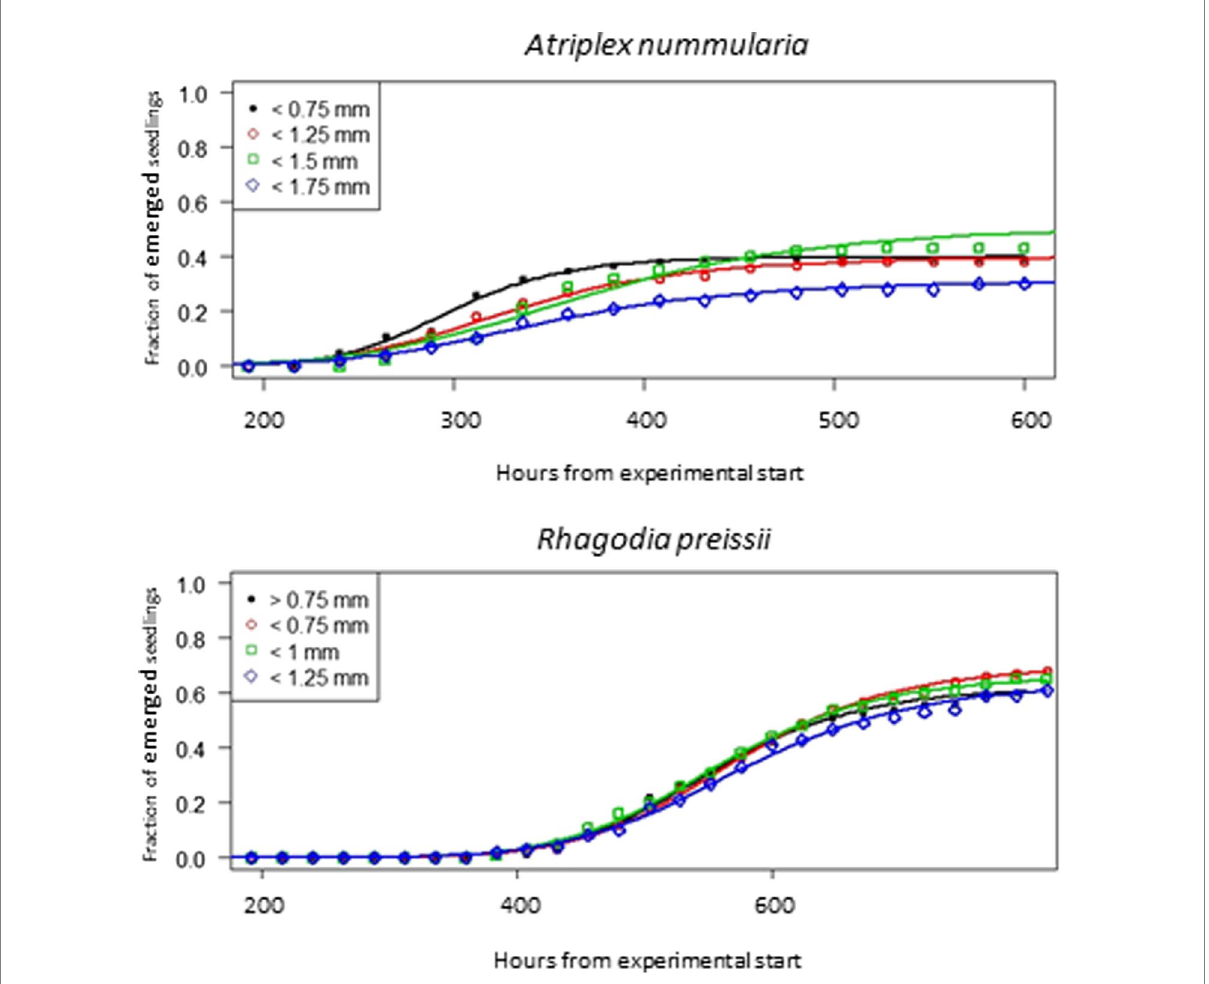
FIGURE 6 Emergence curves for four different seed size fractions of A. nummularia and R. preissii sown in 5 mm depth in